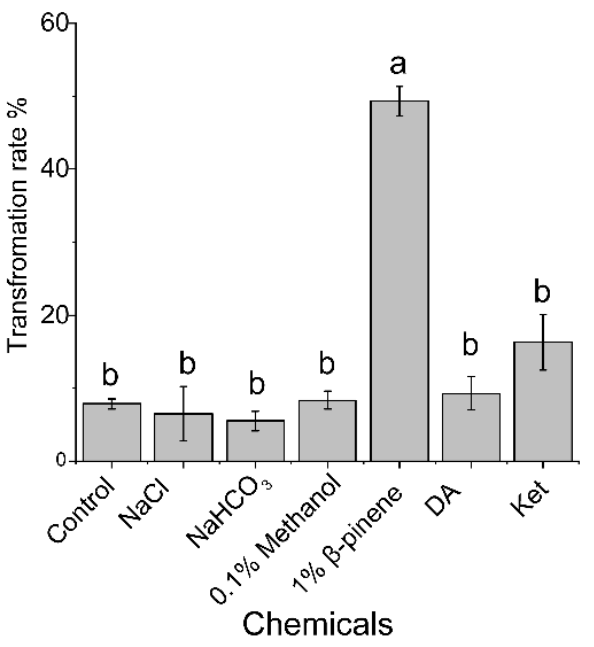
Figure 1. Transformation rate of dauer juveniles (J IV ) of Bursaphelenchus xylophilus , promoted by differ- ent signal chemicals. Dafachornic acid (DA) and ketoconazole (ket) were used in this study. Statistical differences in the means are indicated with different letters, p < 0.05. Error bars represent ± SE.